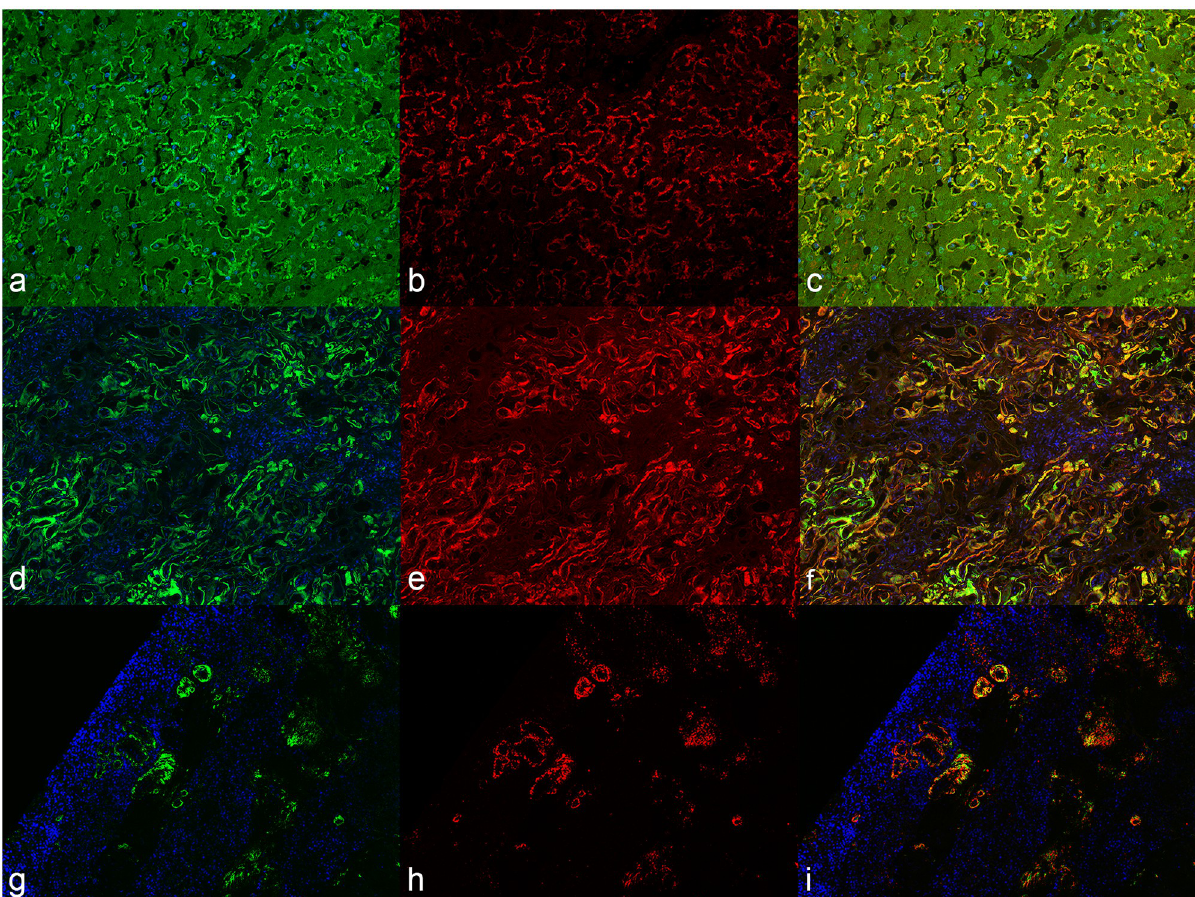
Fig 1. Amyloidosis, cat, fluorescence-immunohistochemistry for AA-amyloidosis. Tissue were stained with Thioflavine S (ThioS) to confirm the presence of amyloidogenic aggregates [a, d, g, left column, ThioS in green, 4’,6-diamidino-2-phenylindole (DAPI) in blue] and with an IgG derived from mice immunized with Q β -AA peptide vaccine (b, e, h, middle column, IgG in red). A co-localization staining of ThioS and IgG (c, f, i, right column, merge) was generated to authenticate the specificity of the IgGs. a, b, c) Liver. d, e, f) Kidney. g, h, i) Spleen.